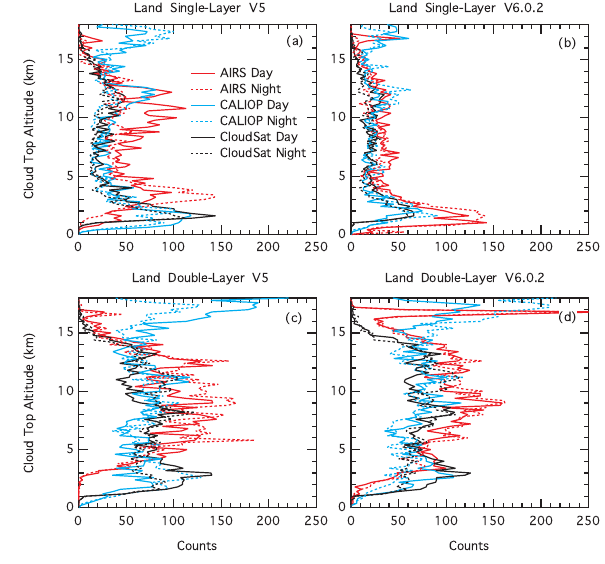
Fig. 3. Cloud top height Z C frequency for AIRS v5 (left column) and v6 (right column) over the ocean for single-layered cases (up- per row) and two-layered cases (lower row) for a one-week period in January 2007. The CloudSat and CALIOP collocated Z C is also shown on each panel. The CloudSat and CALIOP observations are very similar, but not exactly equal to each other, between the dif- ferent panels because of slight changes in the AIRS cloud detection between v5 and v6. seen in Fig. 3, and both are largely consistent with the active sensors.